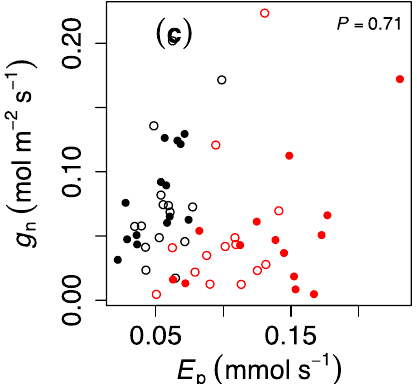
Figure 3. Relationship between nocturnal stomatal conductance ( g n ) and ( a ) daytime stomatal conductance ( g d ,), ( b ) net assimilation ( A net ,), and ( c ) whole plant transpiration ( E p ). Black and red values indicate ambient temperature and heat wave, respectively, and open and closed symbols indicate ambient and elevated CO 2 concentrations, respectively. P -values indicate the result of least-squares fitting. Each value represents a single genotype.